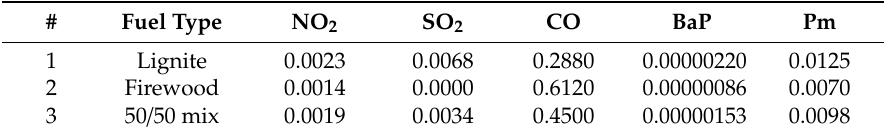
Table 6. Emissions per one private household heated individually without a centralized system, kg /